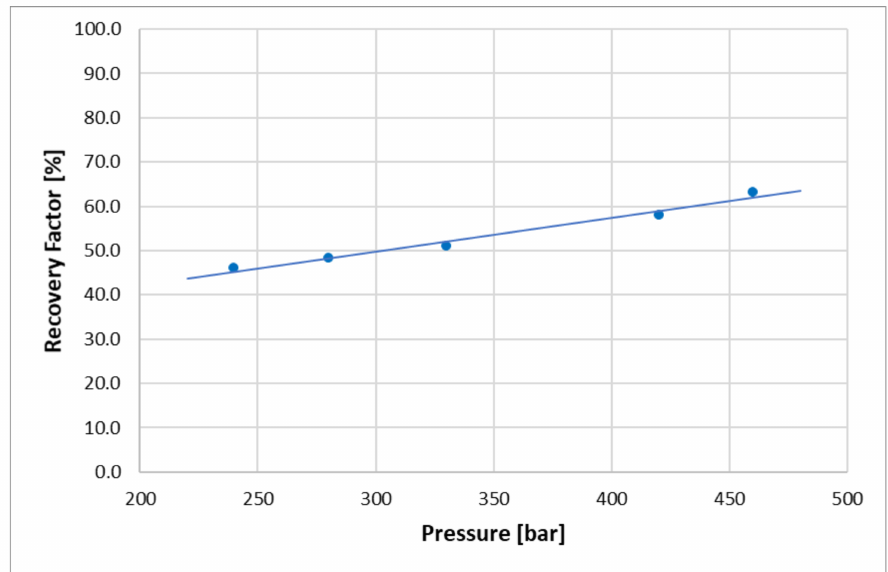
Figure 10. Slim tube recovery factors for MG plotted against pressure.